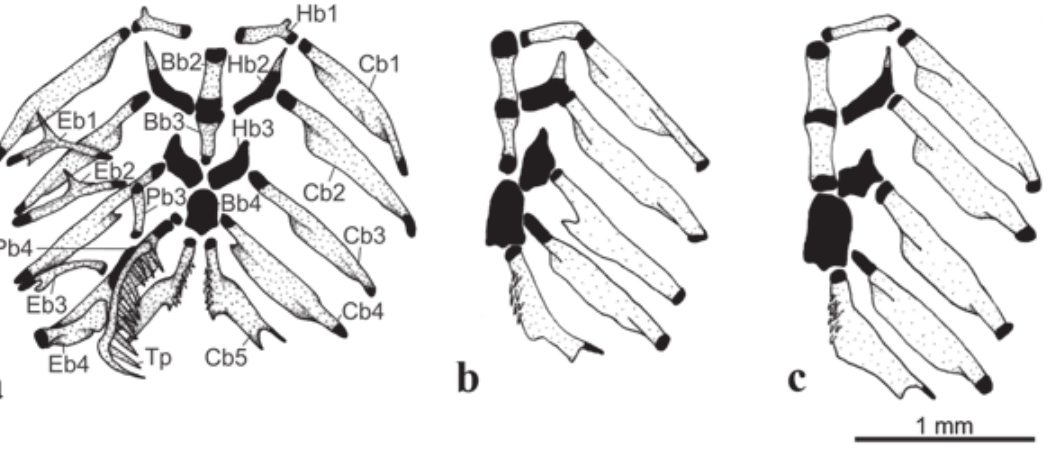
Fig. 3. Gill arches of ( a ) Listrura costai , new species, UFRJ 6577, paratype, 34.3 mm SL, ( b ) L. nematopteryx , UFRJ 5952, 29.4 mm SL, and ( c ) L. picinguabae , UFRJ 5951, paratype, 35.5 mm SL, dorsal view. Right dorsal elements of L. costai and left ventral and all dorsal elements of both L. nematopteryx and L. picinguabae not drawn. Bb2-4 - basibranchials 2 to 4; Cb1-5 - ceratobranchials 1 to 5; Eb1-4 - epibranchials 1 to 4; Hb1-4 - hypobranchials 1 to 4; Pb3-4 - pharyngobranchials 3 and 4; Tp - tooth plate. Deep depression on ventral hypohyal for articulation with urohyal condyle. Anterior ceratohyal cylindrical and constricted at midlengh. Posterior ceratohyal nearly triangular. Interceratohyal cartilage narrow. Cleithrum flattened, slightly triangular and with large fenestra on central region (Fig. 6d). Scapulocoracoid narrow, fully cartilaginous and with narrow process on distal portion. Single proximal radial rounded and fully cartilaginous. Single pectoral-fin ray narrow and segmented.